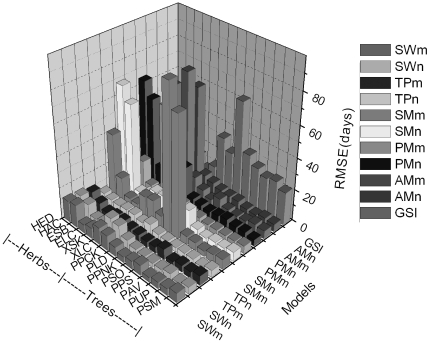
The root mean square error (RMSE) of different phenology models for plant leafing using independent data.Tree species include PSM=Salix matsudana; PUP=Ulmus pumila; PAV=Armeniaca vulgaris; PPS=Populus simonii; PSO=Syringa oblate; PPNK=Pinus koraiensis; PLD=Larix dahurica; and PPCK=Picea koraiensis. Herbs include XLC=Leymus chinensis in Xilinhot; XSK=Stipa krylovii; HED=Elymus dahuricus; HAC=Agropyron cristatum; ELC=Leymus chinensis in Ewenki; and ESB=Stipa baicalensis. SWn, TPn, and AMn: Spring warming model (SW), Temperature-precipitation based leafing model (TP), and Alternating model (AM) with fixed starting date. SWm, TPm, and AMm: SW, TP and AM with parameterized starting date. SMn and PMn: Sequential model (SM) and Parallel model (PM) with section parameters estimated. SMm and PMm: SM and PM with all parameters estimated. GSI: Growth season index.